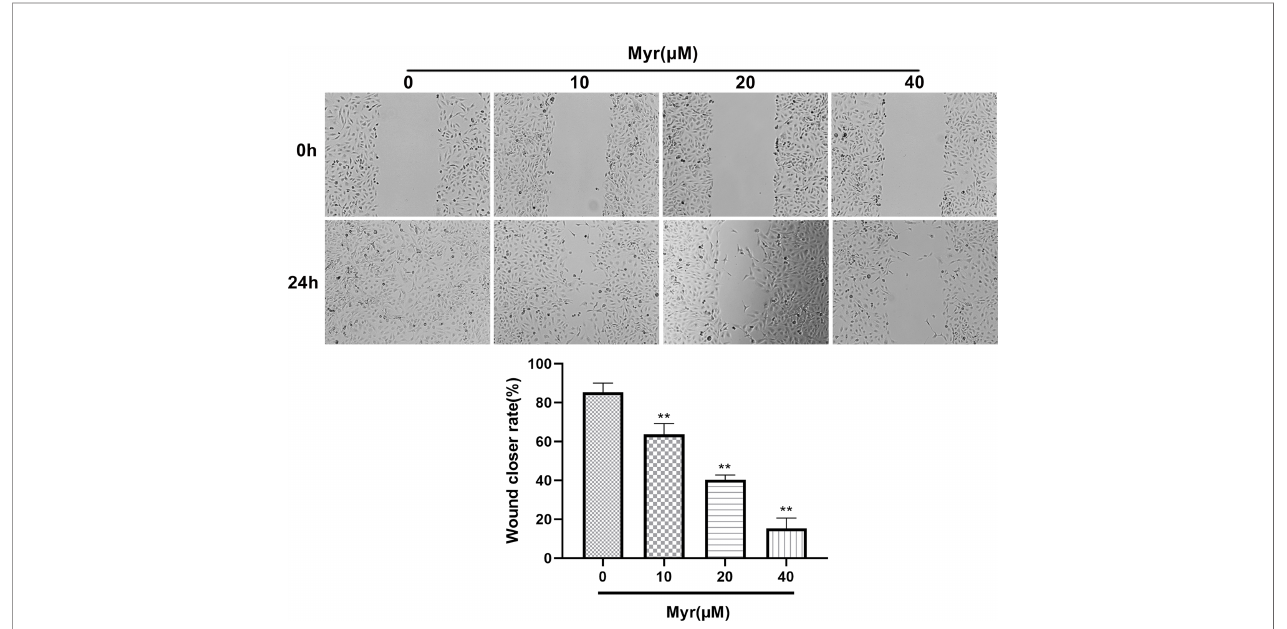
FIGURE 3 | Effects of different concentrations of Myr in SKOV3 wound healing. After treating SKOV3 cells with Myr at 0, 10, 20 and 40 m M for 24 h, cell migration was analyzed using a wound healing assay and microscopy at ×40 magni fi cation. n=3; ** p <0.01 vs.